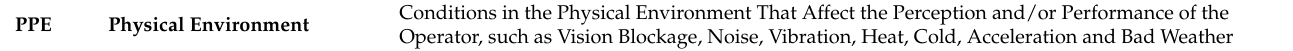
Table A2. Codes, titles, definitions, and guidance and examples of categories and factors in